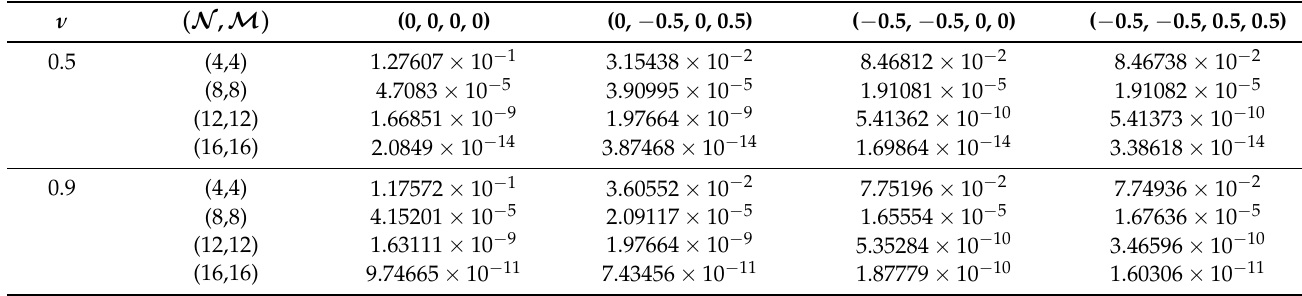
for problem (33). U